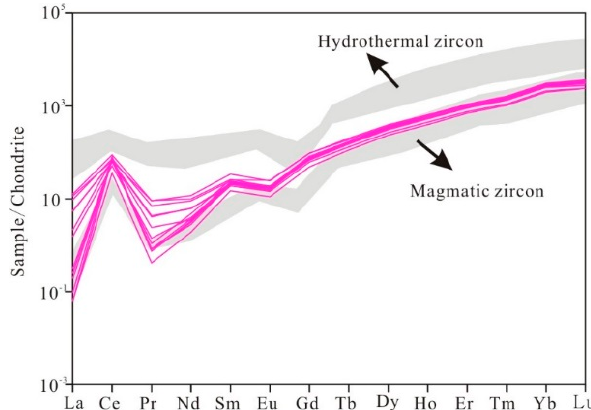
Figure 9. Chondrite-normalized REE patterns of the zircon from the Xiajinbao granite.